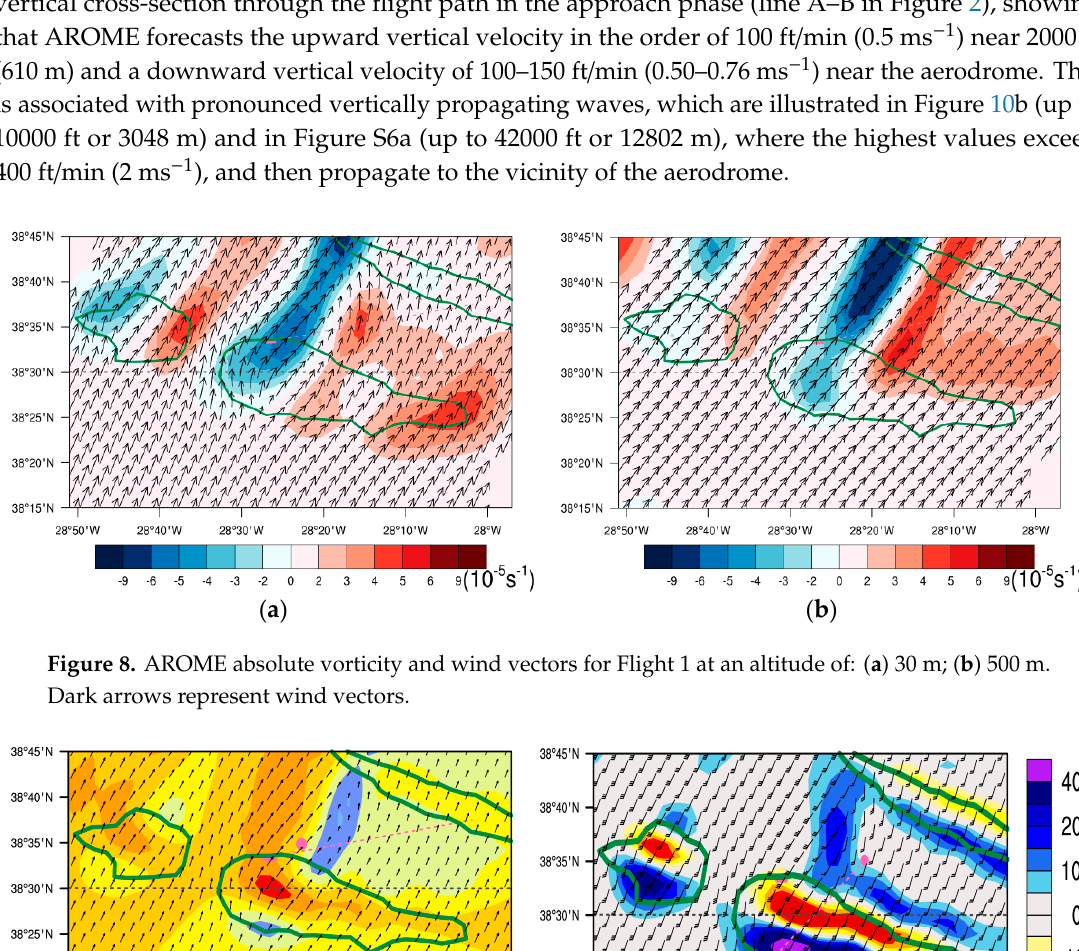
( b ) Figure 10. Vertical cross-section of the vertical velocity of AROME through ( a ) line A–B on Figure 2 and (b) line C–D on Figure 2, for Flight 1. Shading represents intensity in ft/min, positive values indicate upward vertical velocity and negative values represent downward vertical velocity. The altitude scale of (a) is half of the corresponding scale of ( b ). 3.3.2. Characterization of Orographic Flow during Flight 2 The horizontal wind and vertical component of the absolute vorticity predicted by the AROME model at several heights are presented in Figure 11 for Flight 2. Figure 11a depicts a stagnation area in the windward direction of Pico Mountain and the occurrence of a flow splitting phenomenon in addition to a wake with reversed flow in the lee of the hill. This wake (at 40 m) consists of a pair of vortices, one with a clockwise rotation and negative absolute vorticity and another with a counter-clockwise rotation and positive vorticity. The wake structure exemplified in Figure 11a, which is visible below 600 m (not shown), resembles the results obtained by Smith and Grubiši ć [45] (p.3747) in their study of Hawaii’s wake, which is described as comprising “two large, nearly steady vortices”. A similar structure with a pair of counter-rotating vortices downstream of the obstacle was also documented by Smolarkiewicz and Rotunno [7] (see their Figure 1c) and by Epifanio [4]